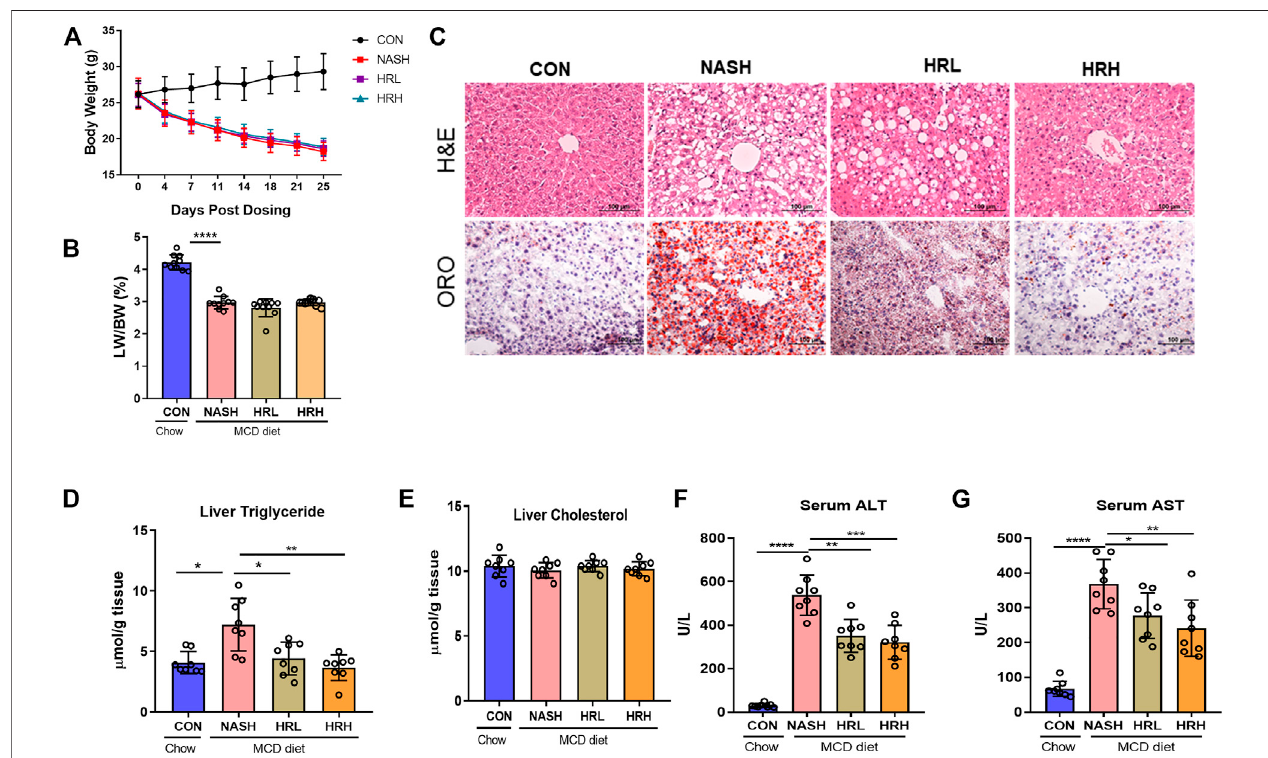
FIGURE 2 | Effects of HZRG on MCD induced NASH mice. (A) Body weight; (B) liver/body weight ratio; (C) Representative H&E and ORO staining images of liver sections (magni fi cation ×200); (D,E) Liver TG and TC content; (F,G) Serum ALT and AST levels. Data are expressed as mean ± SD, 10 animals were allocated for